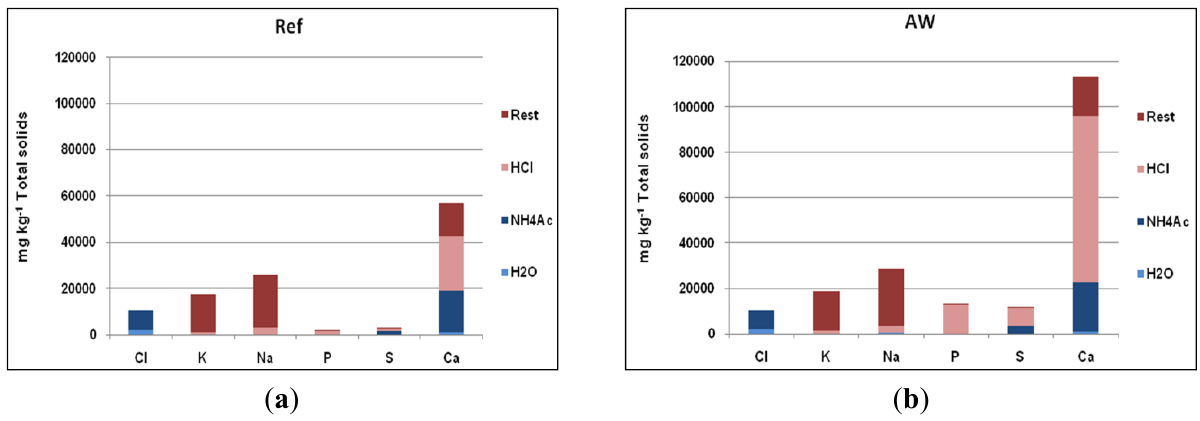
Figure 8. Results of chemical fractionation analysis of return sands with coatings: ( a )